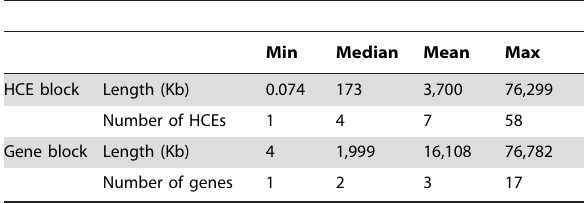
Table 4. The length of HCE/gene blocks and the associated number of